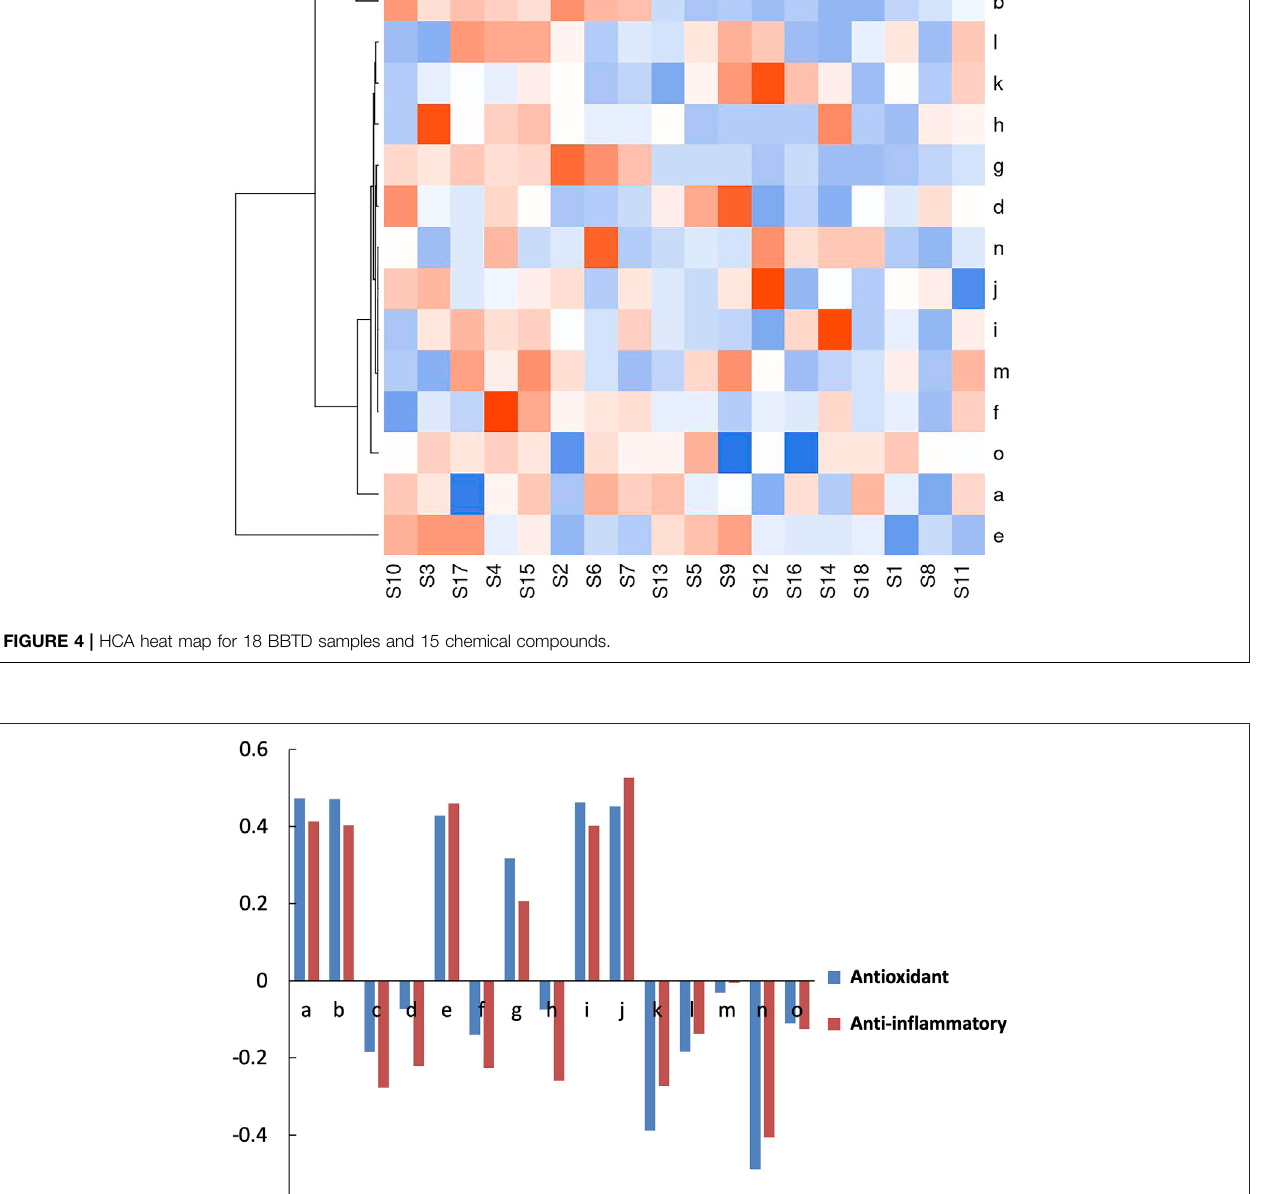
Frontiers in Pharmacology |